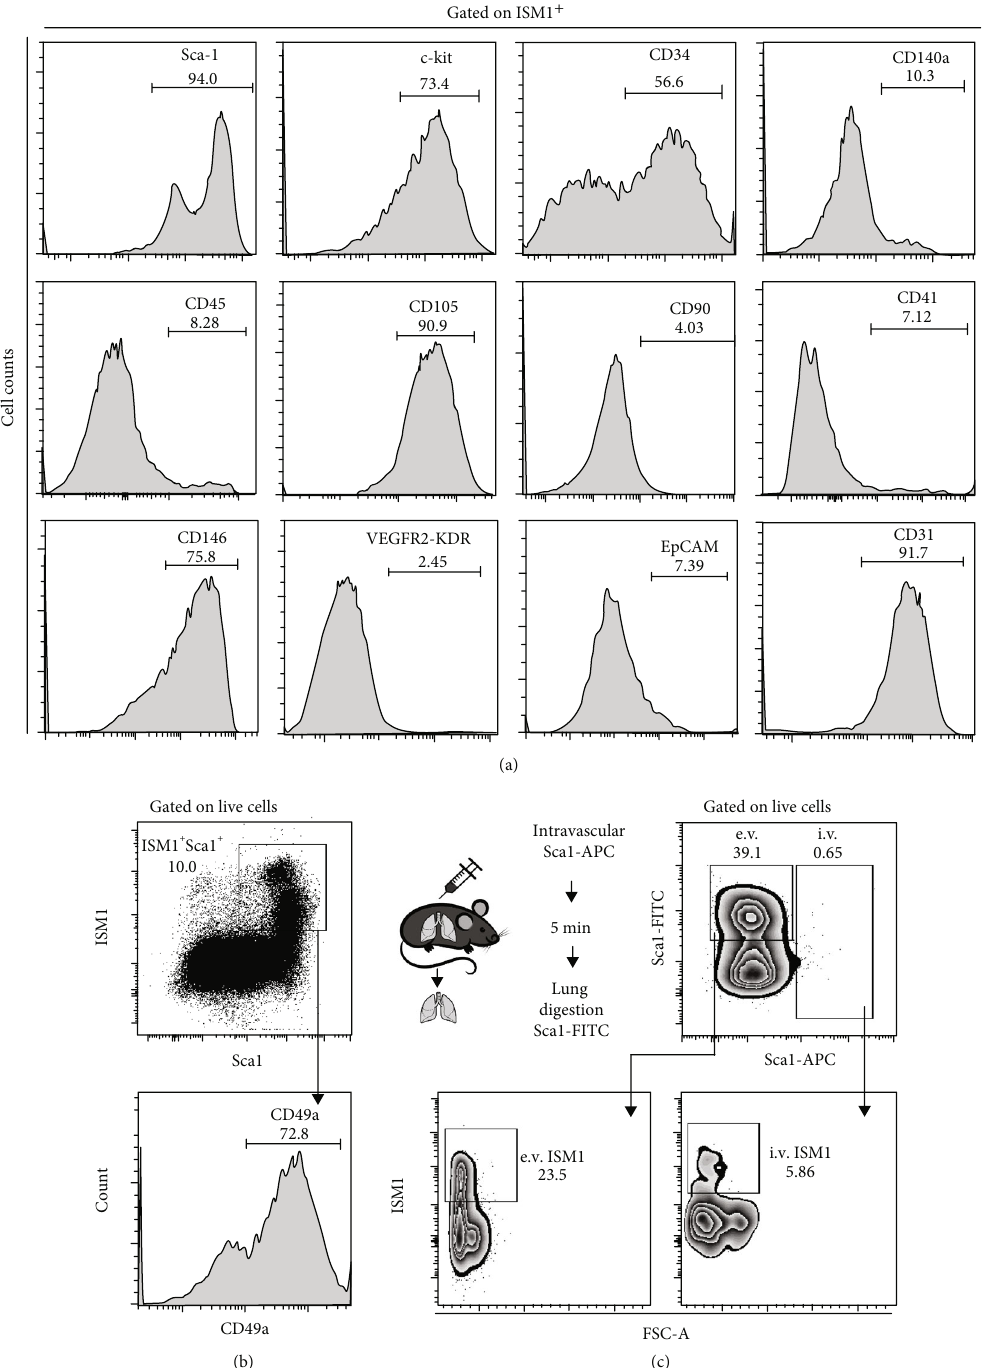
Figure 2: ISM1 + cells have markers of progenitor cells and are lung-resident cells. Lung-derived cells were stained with di ff erent antibodies, and histograms of each marker are depicted. A representative experiment is shown of at least 3 independent experiments. Whole ISM1 + cells were selected as in Figure 1. (b) Lung cells were stained with antibodies to label ISM1, Sca-1, and CD49a. Percentages are shown. (c) WT mice were injected with APC anti-Sca-1, and after 5min, cells were recovered from the lung and stained with FITC anti-Sca-1 and PE anti- ISM1. Percentages in intravascular and extravascular regions are shown. A representative experiment (out of 3) is